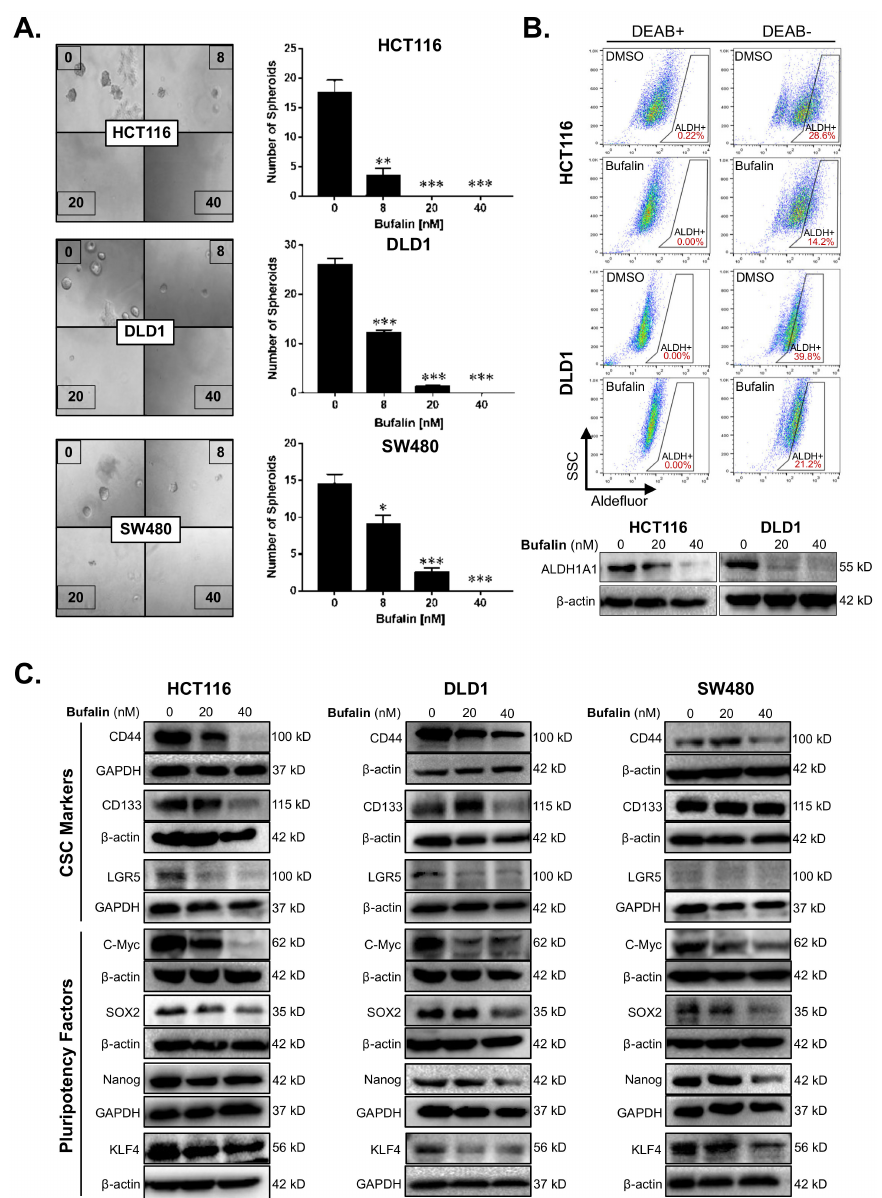
Figure 2. Bufalin inhibits functional stemness, aldehyde dehydrogenase activity, and the expression of CSC/pluripotency markers in colorectal cancer cells. ( A ) Matrigel spheroid formation assay results showing that treatment with 8–40 nM bufalin can significantly reduce the number of spheroids formed in HCT116, DLD1, and SW480 cell lines. ( B ) The enzyme activity of ALDH was detected by flow cytometry using DEAB as a gating control, revealing that treatment with 40 nM bufalin significantly reduces ALDH+ HCT116 and DLD1 cells, which was confirmed by Western blot. ( C ) Bufalin inhibits the expression of CSC markers CD44, CD133, and LGR5, as well as the pluripotency factors C-Myc, SOX2, Nanog, and KLF4 in a cell line-dependent manner (* p < 0.05, ** p < 0.01, *** p < 0.001, images at 10 ×